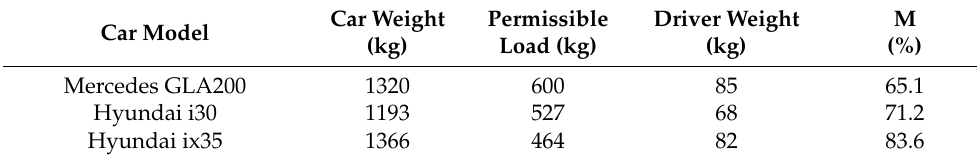
Table 2. Technical data of the cars used in experiment and driver’s weight. Car